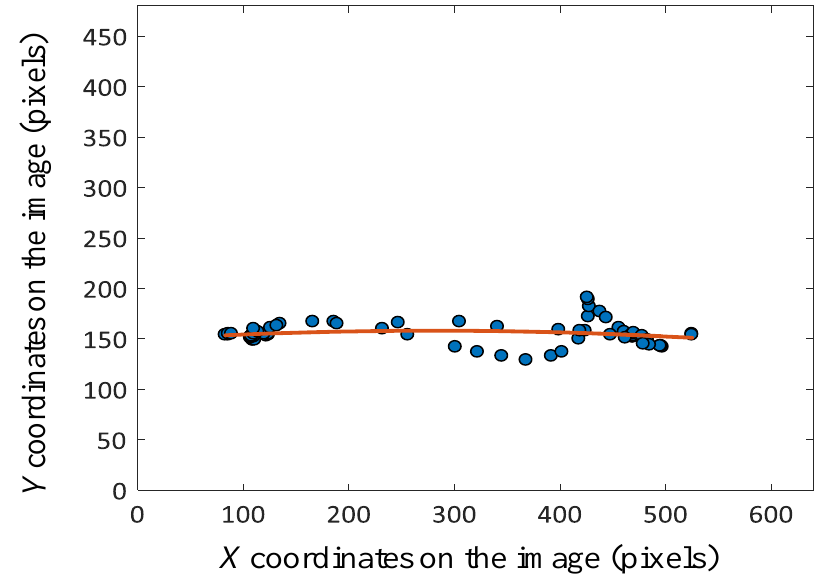
Figure 5. Plot of finger trajectory and approximate curve.